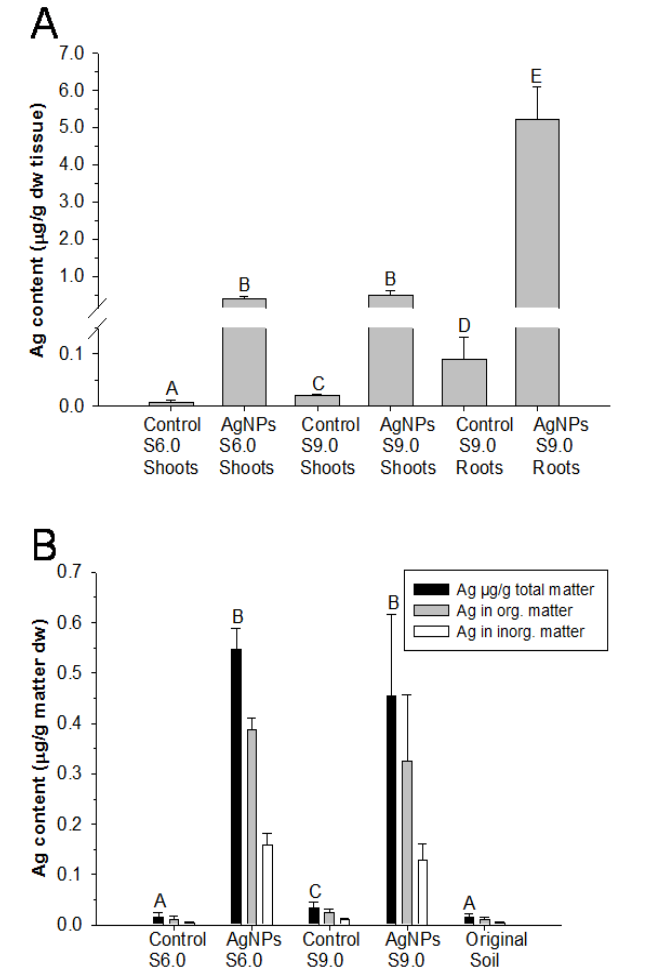
Figure 4. Measurements of silver contents in plant tissues and soil matter. ( A ) Silver accumulation in aboveground parts (shoots) and belowground parts (roots) at the growth stages of S6.0 and S9.0. ( B ) Silver accumulation in AgNP exposed soil after plants were harvested at S6.0 and S9.0 in terms of μ g per g of dry weight of soil sediment with μ g of AgNP relative to the fraction of organic and inorganic matter. The presence of AgNPs in control samples might have been due to human errors, i.e. , misirrigation of AgNP suspension instead of ddH 2 O. See the Materials and Methods for the definition of dry weight, organic and inorganic matter. Different letters indicate significantly different soil or tissue concentrations ( t -tests, p = 0.05). Abbreviations: dw, dry weight; inorg, inorganic; org, organic; original soil, potting soil from Fafard R 4M